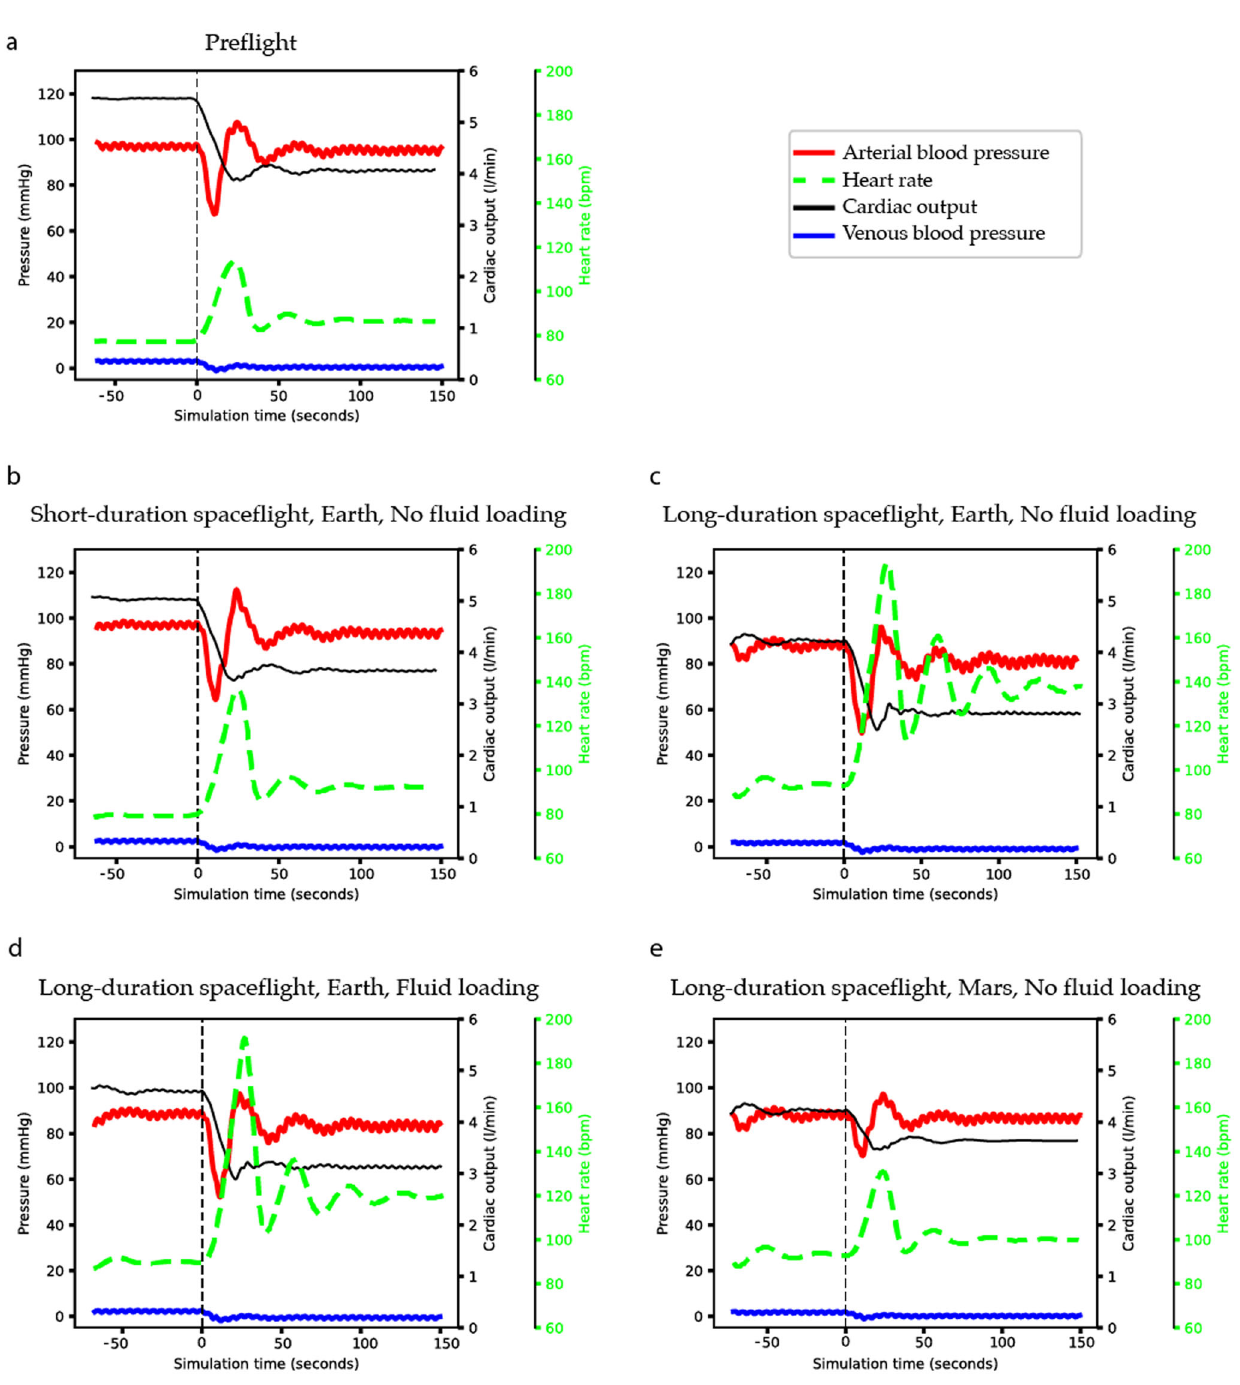
Fig. 2 Hemodynamic responses to stand test pre- fl ight and on landing day under different conditions. a Is pre- fl ight, b Landing day after short-duration space fl ight (<10 days), c Long-duration space fl ight, no fl uid loading, and Earth ’ s gravity, d Long-duration space fl ight, fl uid loading prior to return to Earth, and Earth ’ s gravity, and e Long-duration space fl ight, no fl uid loading, and Mars ’ gravity. Line colours: dashed line = start stand test, red = mean arterial pressure, dashed green = heart rate, black = cardiac output, and blue = central venous